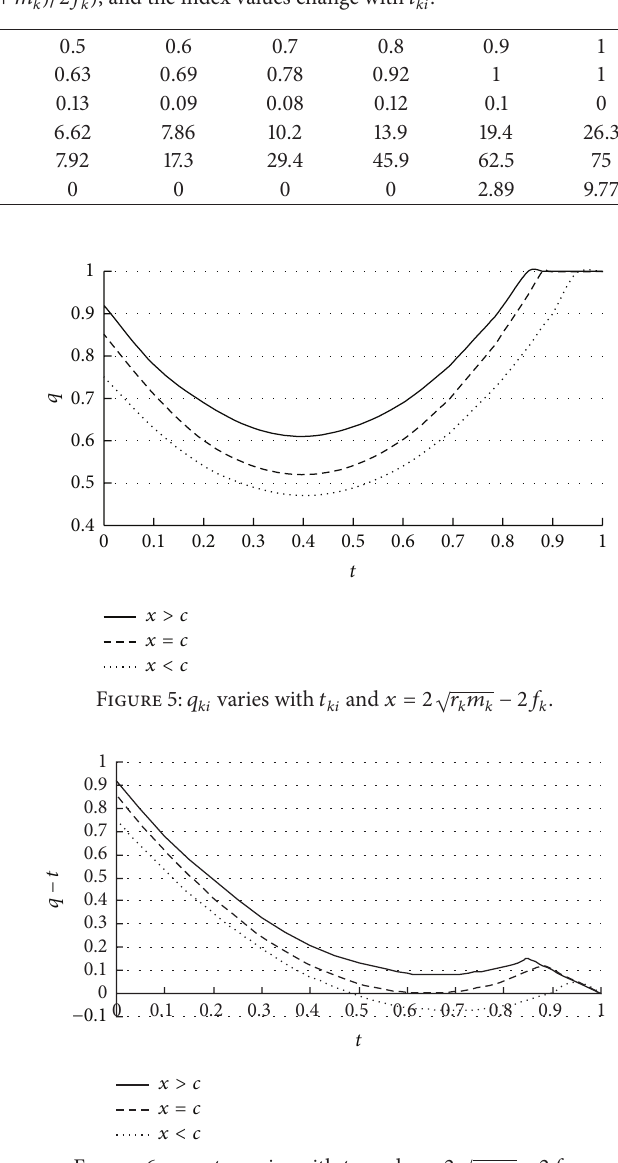
Figure 6: 𝑞 𝑘𝑖 − 𝑡 𝑘𝑖 varies with 𝑡 𝑘𝑖 and 𝑥 = 2 √𝑟 𝑘 𝑚 𝑘 − 2𝑓 𝑘 .